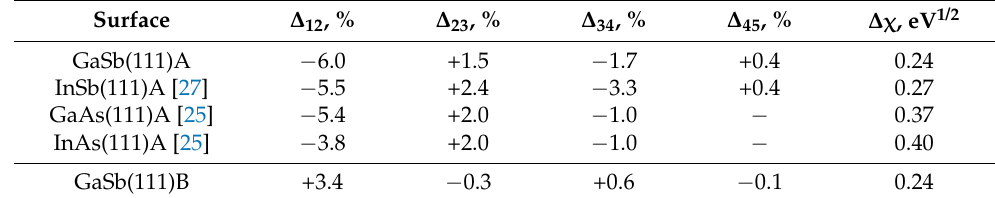
Table 1. Relaxation ( ∆ ij ) of the interlayer distances for two terminations of the GaSb(111) surface.